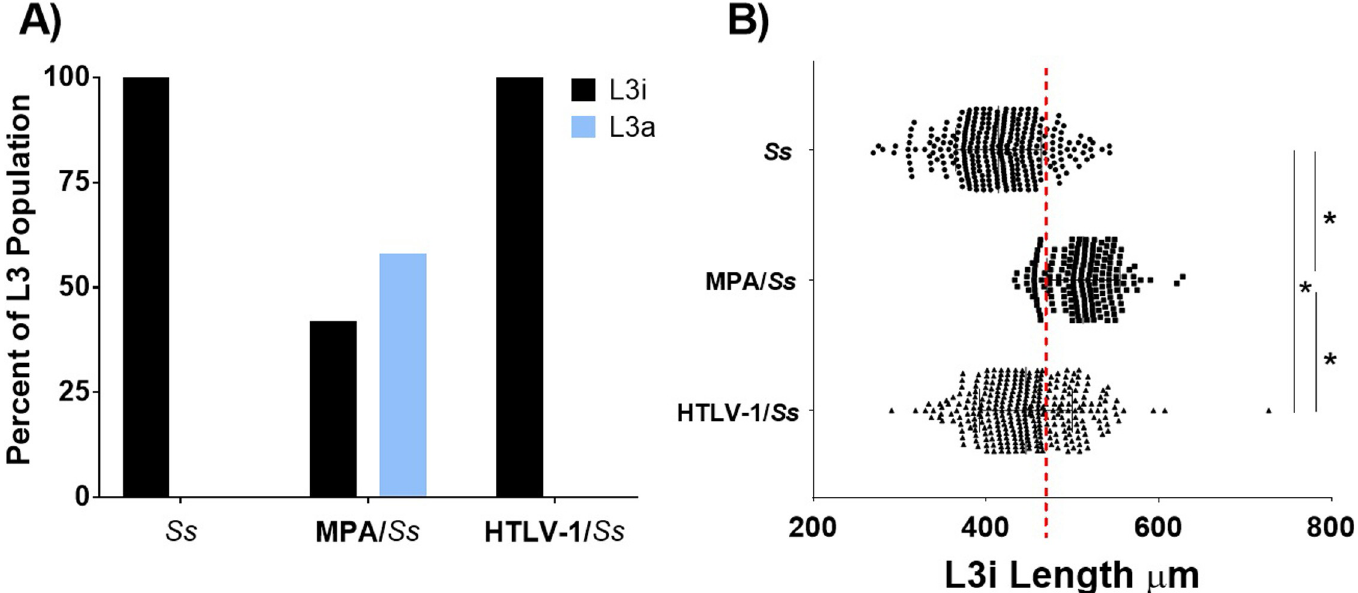
Fig 8. Effects of infection with HTLV-1 or treatment with methylprednisolone acetate (MPA) on the development of Strongyloides stercoralis autoinfective third stage larvae (L3a) and lengths of third-stage larvae (L3i) recovered from humanized NSG mice. Mice were infected with 5,000 S . stercoralis L3i and either treated with MPA or infected with HTLV-1. (A) Percentage of L3i and L3a recovered from the body tissues of S . stercoralis infected animals. (B) Lengths of L3i recovered from the body tissues of S . stercoralis infected humanized NSG mice. Data are a combination of three independent replicate experiments. Asterisk represents p < 0.05. Red dashed line marks 470 μ